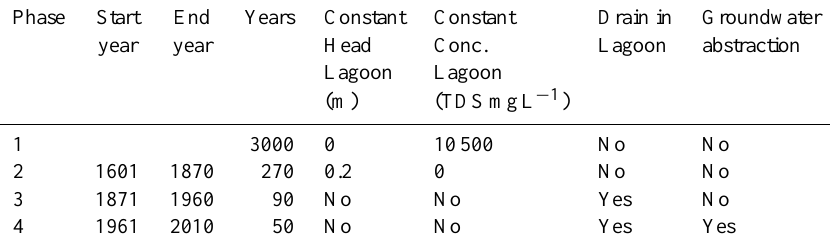
Table 3. Boundary conditions for three model phases.